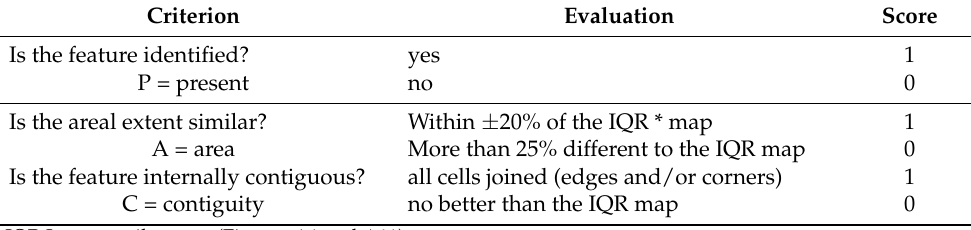
Table A1. Procedure used to rate each cluster map. Binary scoring (yes or no) for each identified feature is designed to discourage subjectivity. Letters P, A, and C refer to codes in Tables 12 and 13. Criterion Evaluation Score Is the feature identified? yes 1 P = present no 0 Is the areal extent similar? Within ± 20% of the IQR * map 1 A = area More than 25% different to the IQR map 0 Is the feature internally contiguous? all cells joined (edges and/or corners) 1 C = contiguity no better than the IQR map 0 * IQR Interquartile range (Figures A1 and